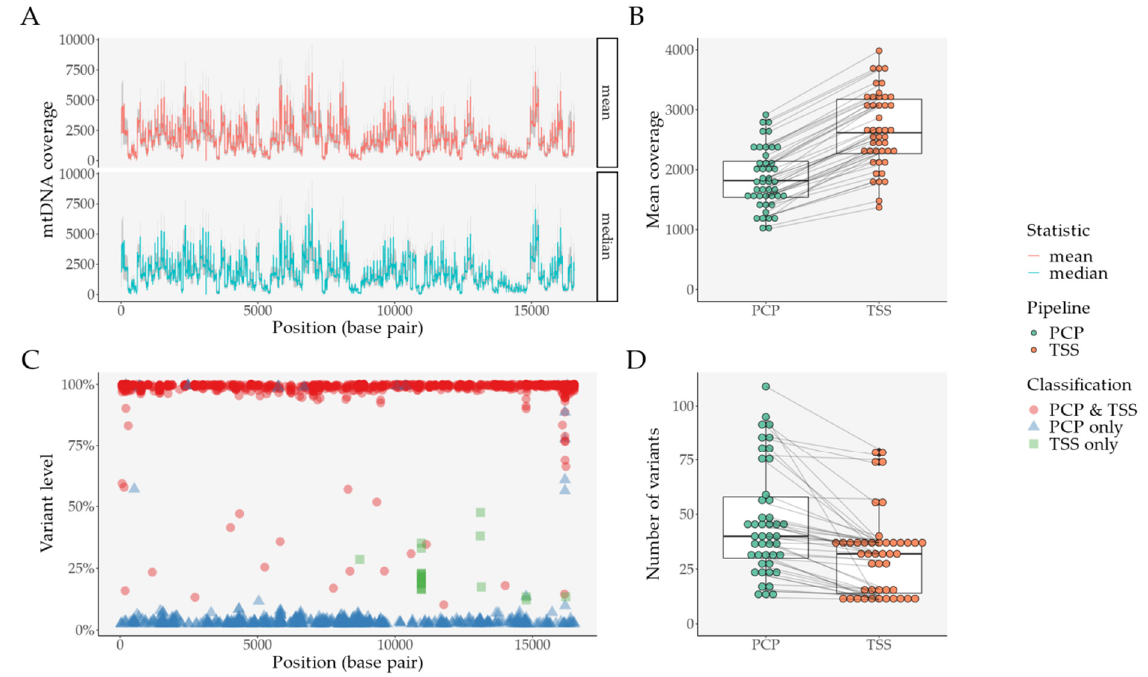
Figure 5. Comparison between PCP and TSS in an independent set of samples (after filtering, N = 45) derived from clinical practice (an ischemic stroke prospective cohort). ( A ) Coverage per base pair with PCP data, per statistic (mean and median)—the grey area represents the standard deviation of each statistic per base pair; ( B ) Mean coverage per sample and per pipeline—lines connect the same sample; ( C ) Distribution of variants per base pair and per variant classification—for variants found in PCP and TSS, mean variant level was plotted; ( D ) Mean number of variants per sample and per pipeline—lines connect the same sample. Abbreviations: PCP—PrecisionCallerPipeline; TSS—Ion Torrent Suite™ Software.